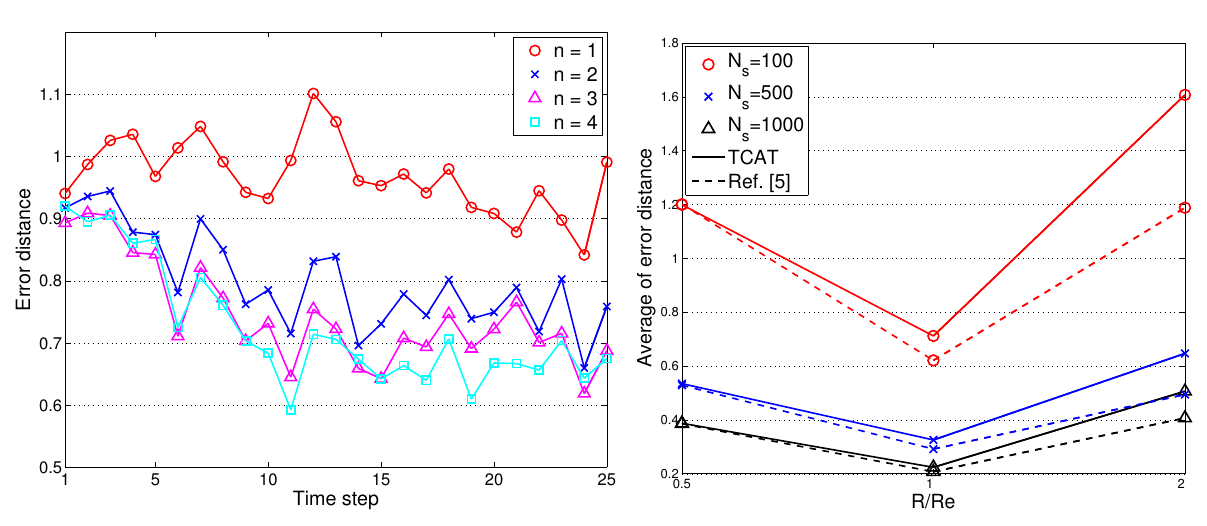
Figure 12. The target localization error ( left ); the estimation error with n = 2 and various ratios of R/R ( right e